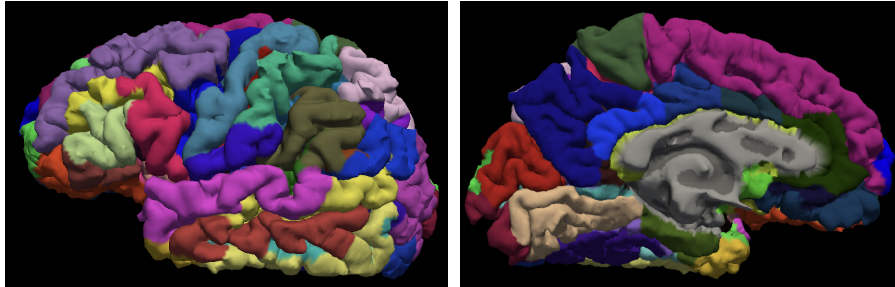
Figure 1. Cortical parcellation of the left hemisphere according to the Destriaux